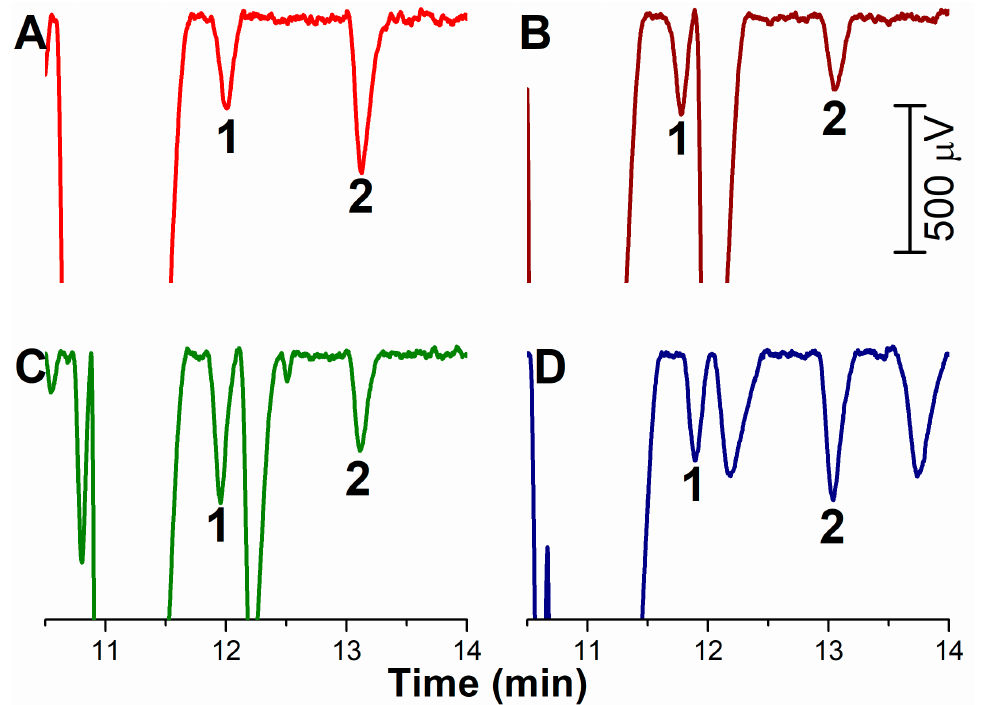
Figure 4. CE/C 4 D analysis of ADMA (1) and SDMA (2) in various samples of human plasma with concentrations determined as ( A ) 0.45 µ M ADMA and 0.70 µ M SDMA; ( B ) 0.36 µ M ADMA and 0.32 µ M SDMA; ( C ) 0.62 µ M ADMA and 0.38 µ M SDMA; ( D ) 0.44 µ M ADMA and 0.70 µ M